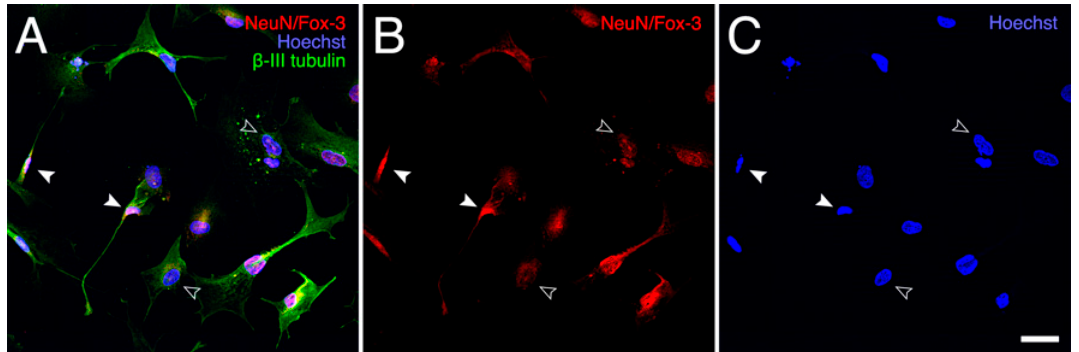
Figure A1. Representative image of stained AraC-treated NT2 cells used for morphometric analysis. Double immunofluorescence labeling using antibodies against the neuronal and postmitotic neuron markers β -III tubulin (green) and NeuN/Fox-3 (red), respectively. Cell nuclei were counterstained with the chromatin marker Hoechst 33342 (blue) ( A ). Staining corresponds to the NeuN/Fox-3 ( B ) and Hoechst ( C ) channels. Filled and empty arrowheads depict examples of neuronal and non-neuronal cells, respectively. Scale bar: 50 µm.